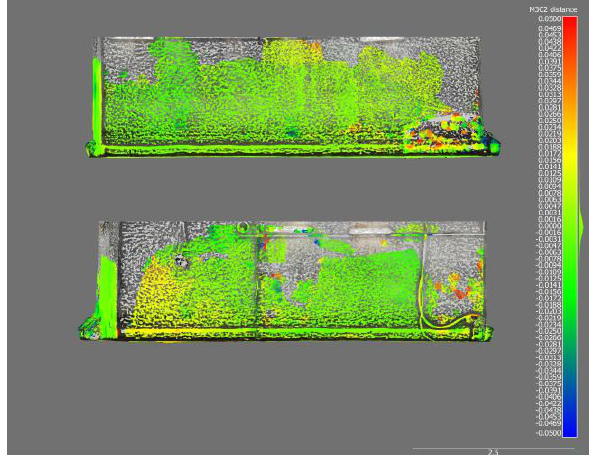
Figure 12. Colour map of the distance (m) between the models on the two long side